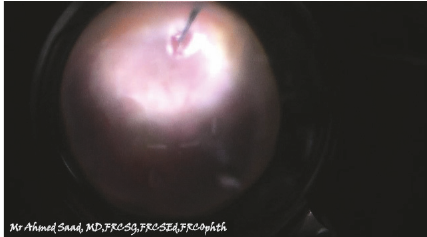
Figure 5: Subretinal biopsy through vitrectomy.